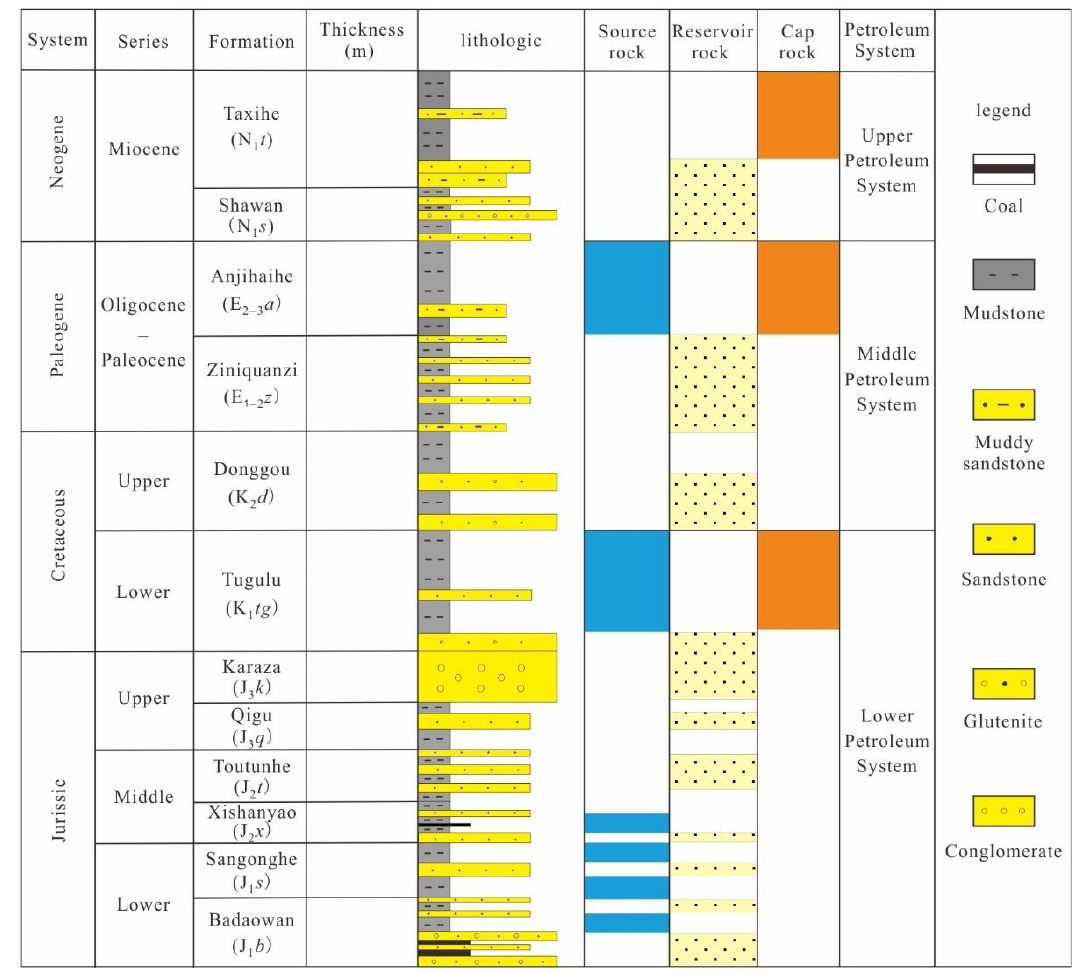
Figure 2. Comprehensive stratigraphic histogram.